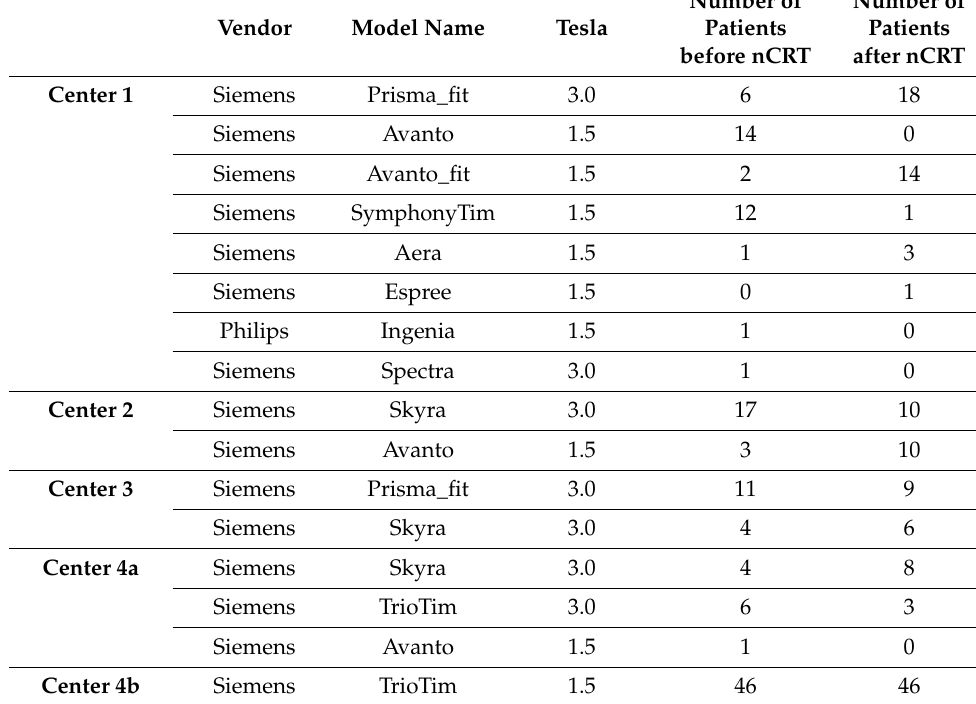
Number of Number of Patients Patients after nCRT before nCRT